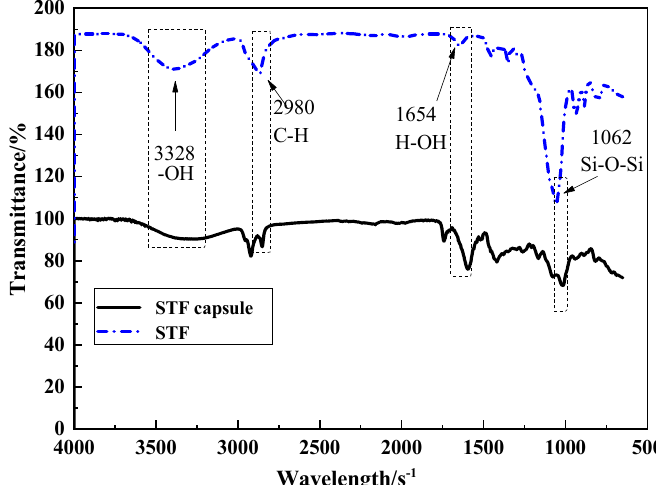
Figure 10. Fourier transform infrared spectroscopy (FTIR) spectra of STF capsule, W/O/W multiple emulsion and STF.